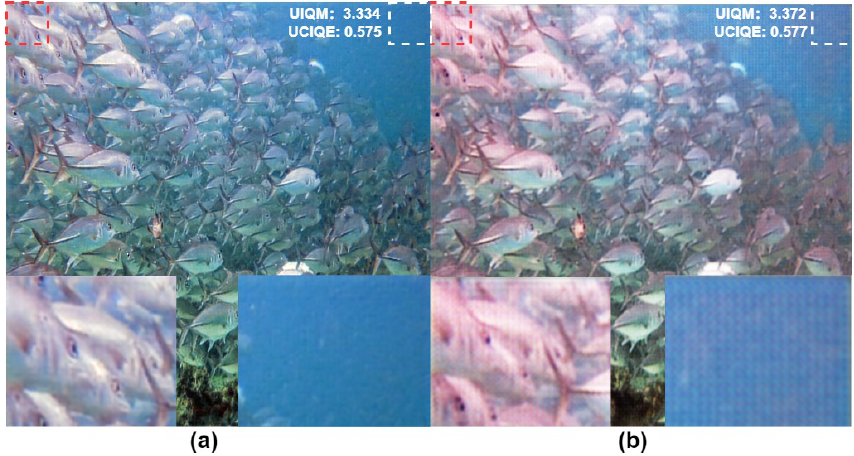
Figure 5. Test-C60 visual image comparison. Here, we can see the difference between our image and the UGAN image. We do not have any clear pixel cubes, and the contrast and color difference of the objects are better. ( a ) Ours, ( b ) UGAN [11].